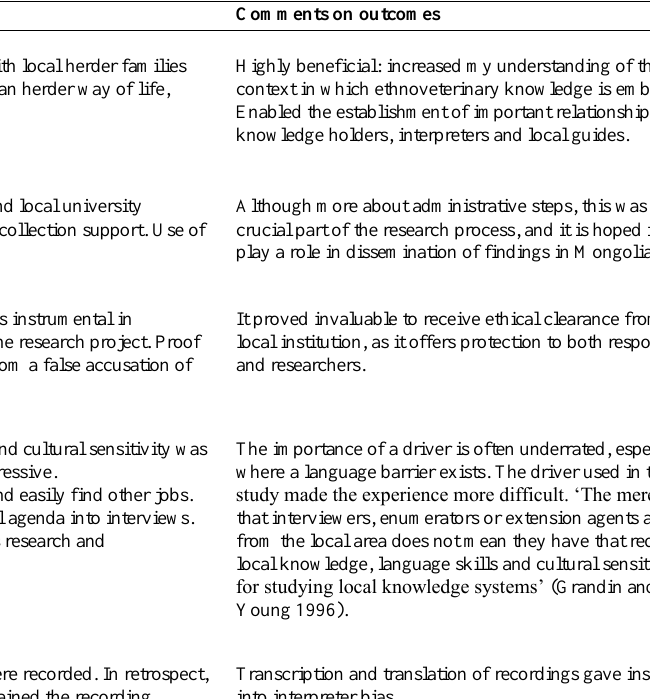
Table 1. Theory versus practise: a review of the methods and approaches used for ethnoveterinary research conducted in